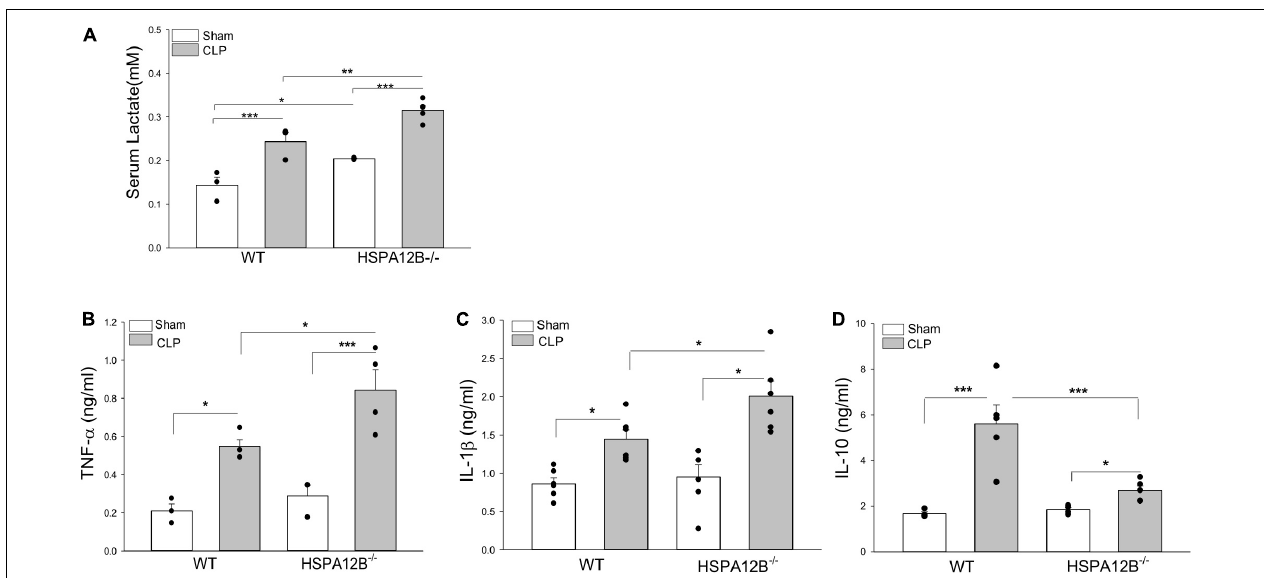
FIGURE 3 | Increased serum levels of lactate and inflammatory cytokines in HSPA12B − / − septic mice. WT and HSPA12B − / − mice were subjected to a CLP sepsis. Serum was collected at 36 h after CLP sepsis. (A) Serum lactate levels at 36 h. (B–D) Serum levels of TNF- α (B) , IL-1 β (C), and IL-10 (D) at 36 h after CLP. n = 3 ∼ 6/group * P < 0.05, ** P < 0.01, and *** P < 0.001 compared with indicated